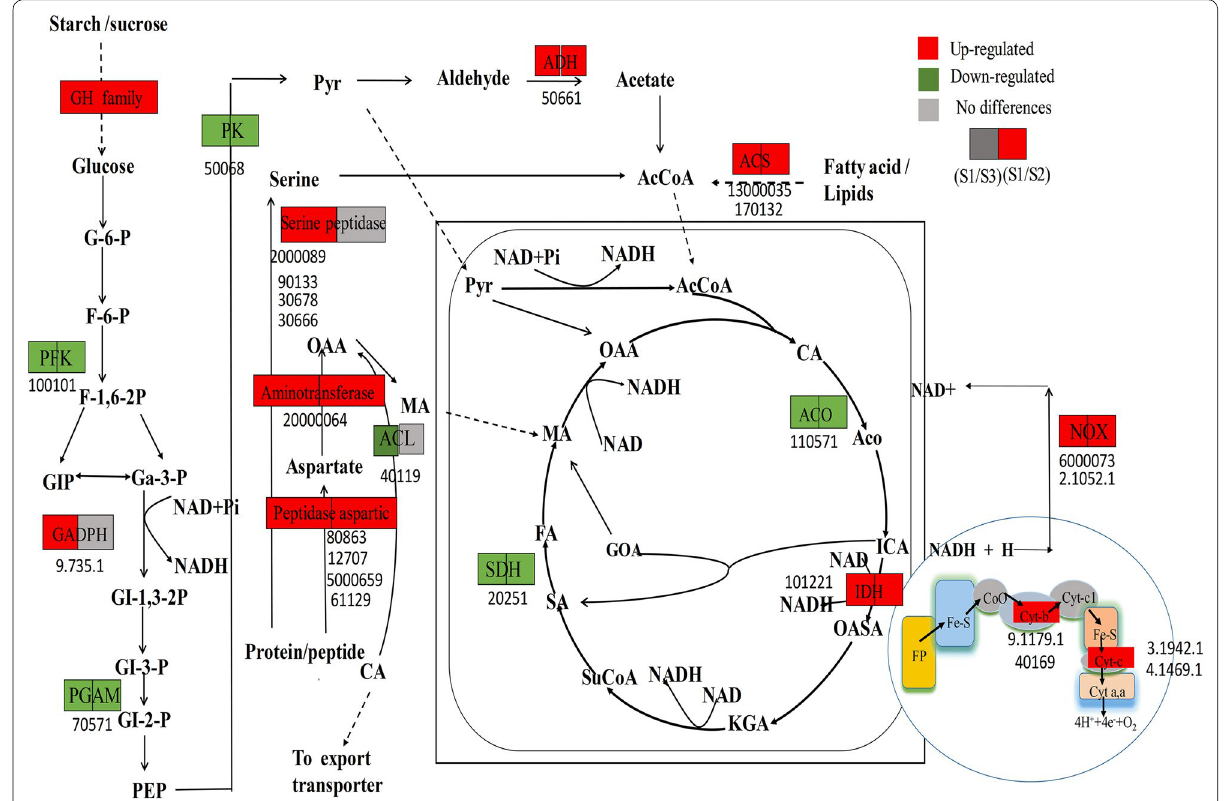
Fig. 6 Transcription level regulation of genes involving CA production in three different A. niger at 40 h. Upregulated, downregulated, and no dif‑ ferentially expressed genes involving CA production are highlighted in red, green, and gray, respectively. Comparative transcriptomic differences of strain YX‑1217 versus ATCC 1015 ( S 1/ S 3) and strain YX‑1217 versus YX‑1217G ( S 1/ S 2) at 40 h are exhibited, respectively, in squares. PFK